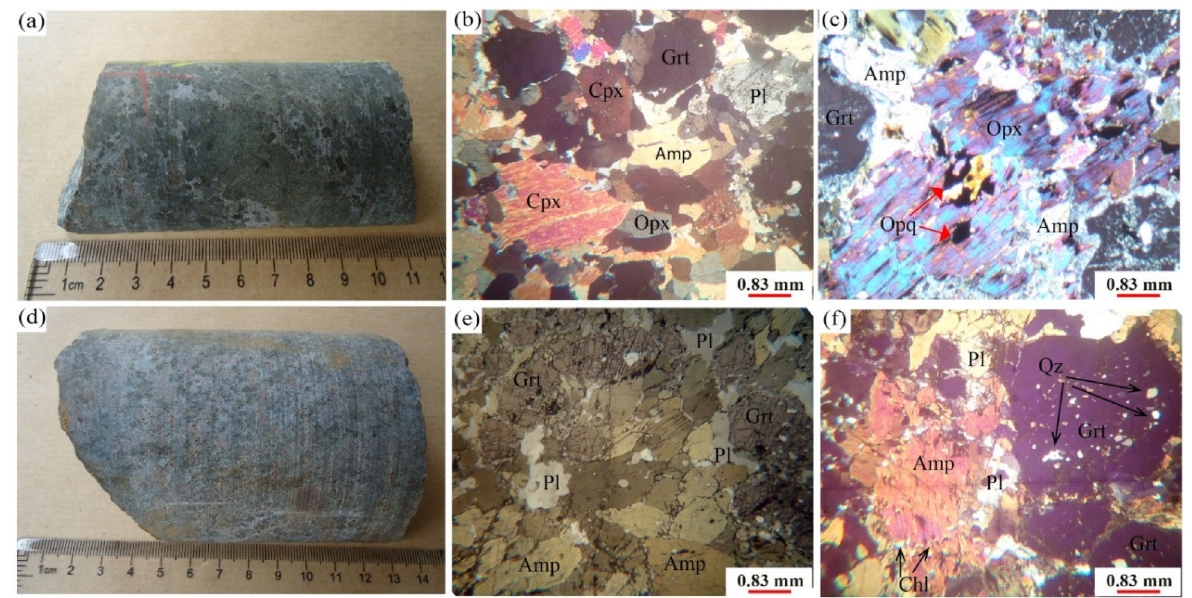
Figure 5. Drill core samples and photomicrographs of the Anyouzok metavolcanic rocks: ( a ) hand specimen of mafic granulite; ( b ) granoblastic heterogranular microstructure with pyroxene, horn- blende, and garnet association (Plane polarized light: PPL); ( c ) anhedral orthopyroxene undergoing transformation into amphibole along the rims; ( d ) core sample of garnet amphibolite; ( e ) granoblastic heterogranular microstructure with amphibole, garnet, and quartz association (PPL); ( f ) amphi- bole grain boundaries partially replaced by chlorite (Cross Polarized Light: XPL). Abbreviations: Grt: garnet; Cpx: clinopyroxene; Opx: orthopyroxene; Amp: amphibole; Qz: quartz; Chl: chlorite; Pl: